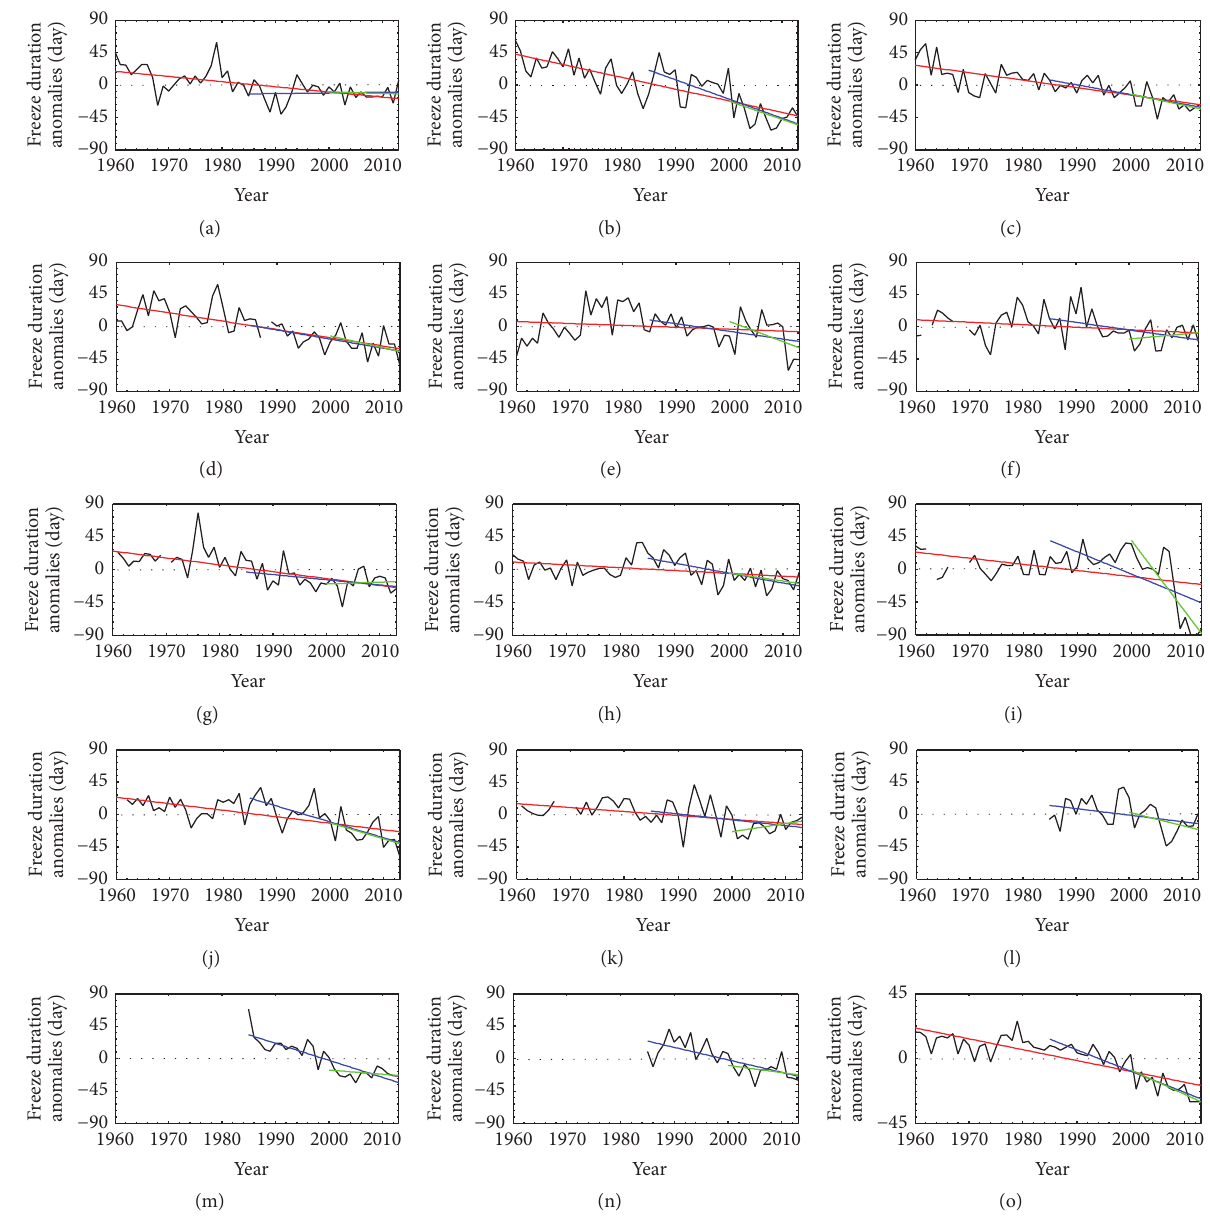
Figure 4: Freeze duration anomaly series during 1960–2014. Linear least squares regression lines are included for 1960–2014 (red line), 1985–2014 (blue line), and 2000–2014 (green line). (a) Xinghai station, (b) Tongde station, (c) Zeku station, (d) Zaduo station, (e) Yushu station, (f) Guoluo station, (g) Dari station, (h) Henan station, (i) Ruoergai station, (j) Nangqian station, (k) Changdu station, (l) Zhiduo station, (m) Qumalai station, (n) Maduo station, and (o)